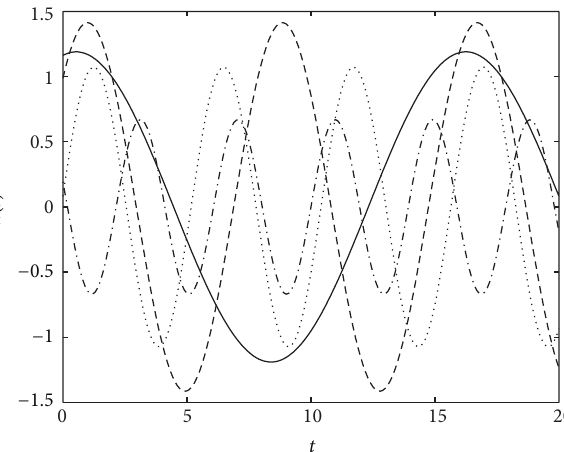
Figure 4: Curves of 𝑥(𝑡) versus 𝑡 for 𝑏 = 1, 𝑐 = 1, and 𝛼 = 1.5 and for 𝜆 = 0.4 (solid line), 𝜆 = 0.8 (dashed line), 𝜆 = 1.2 (doted line), and 𝜆 = 1.6 (doted-dashed